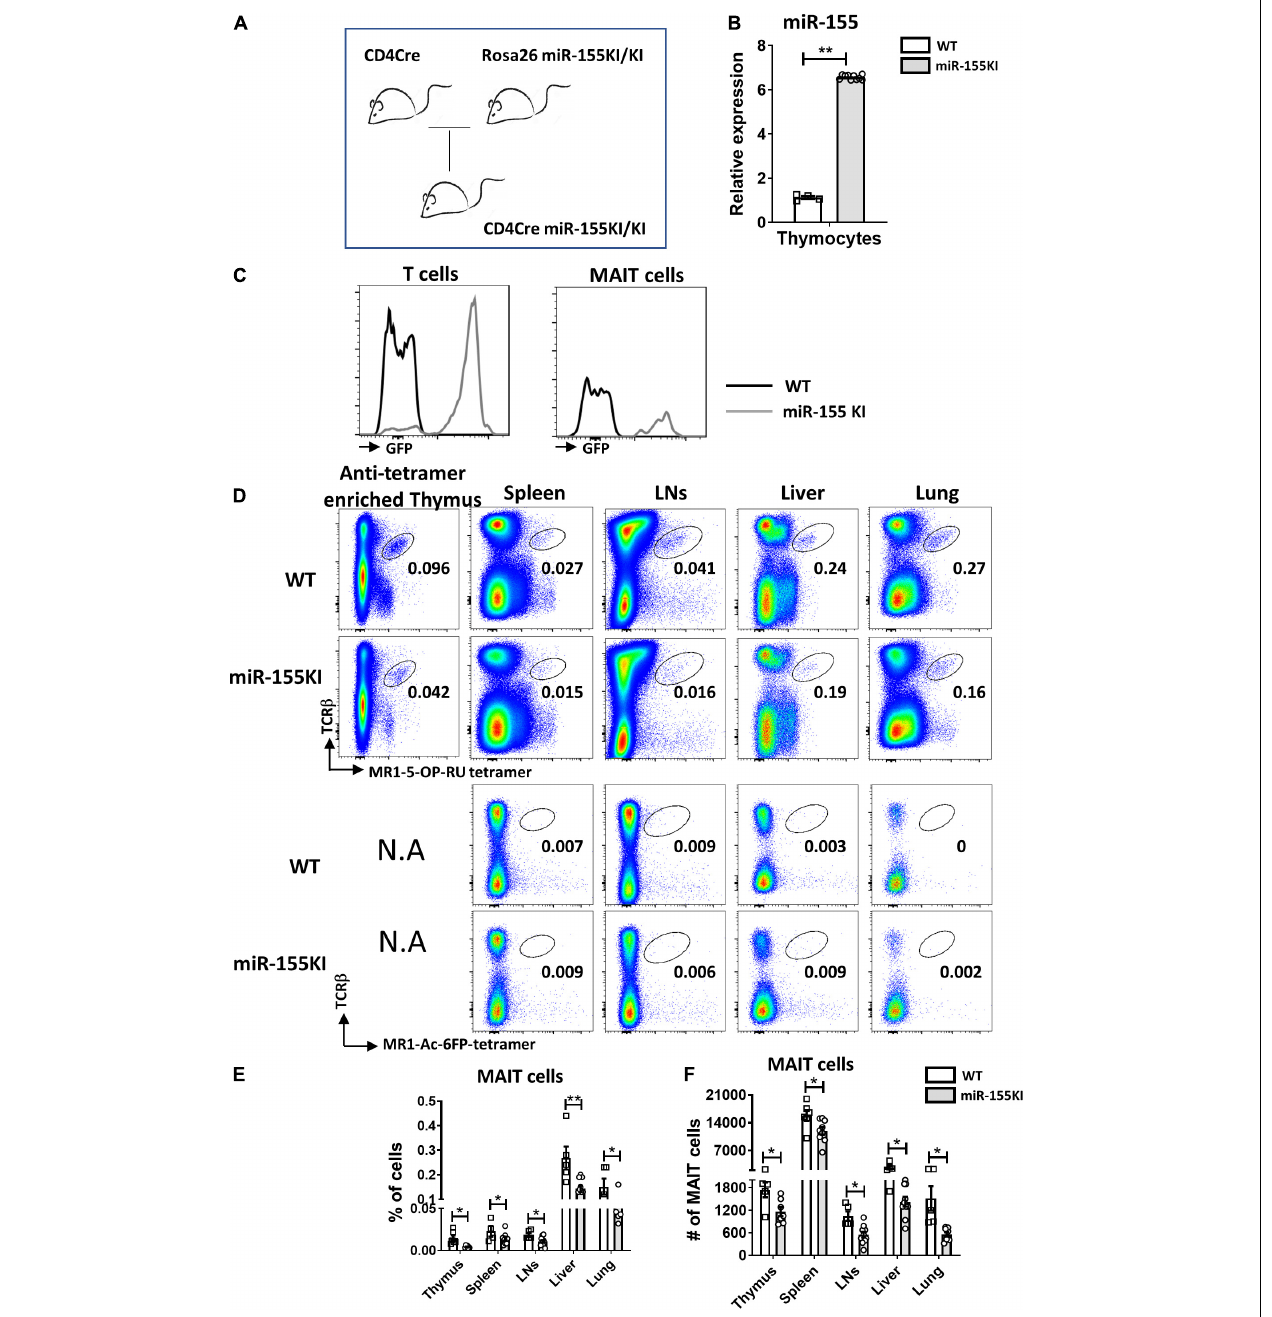
FIGURE 1 | miR-155 overexpression interferes MAIT cell development. (A) CD4Cre miR-155 KI mouse model. (B) Thymic T cells were harvested from WT controls and miR-155 KI mice. Total RNA was purified and miR-155 and snoRNU202 expression was measured by RT-PCR. (C) Histogram showing GFP expression of T cells and MAIT cells in miR-155KI mice. (D) Defective MAIT cell development in miR-155 KI mice. Representative flow cytometric plots showing the frequencies of MAIT cells in the thymus, spleen, LNs, liver, and lung of WT and miR-155 KI mice. Numbers adjacent to outlined areas indicate frequency of indicated populations. (E) The percentage and (F) the absolute numbers of MAIT cells in indicated organs from miR-155 KI mice. Data are from at least three independent experiments. Each mouse is represented as one dot. 3–8 mice for each group. Data were analyzed by unpaired t -test. * p < 0.05, ** p < 0.01 compared to WT.